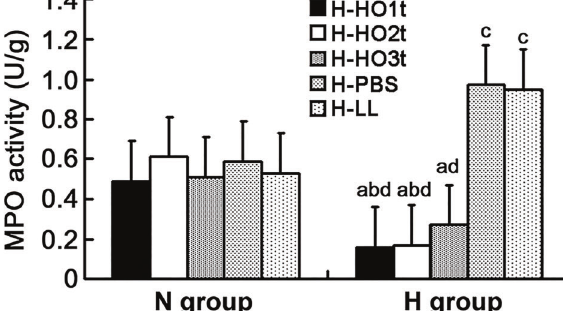
Figure 4. Content of heme oxygenase-1 (HO-1) in the intestine of different N groups treated with Lactococcus lactis expressing heme oxygenase-1 once (HO1t), twice (HO2t) or thrice (HO3t) or with phosphate-buffered saline (PBS) and L. lactis (LL) (ng/g). a P o 0.05: compared with PBS and LL groups; b P o 0.05: com- pared with HO3t group (ANOVA). Data are reported as means ± SD.